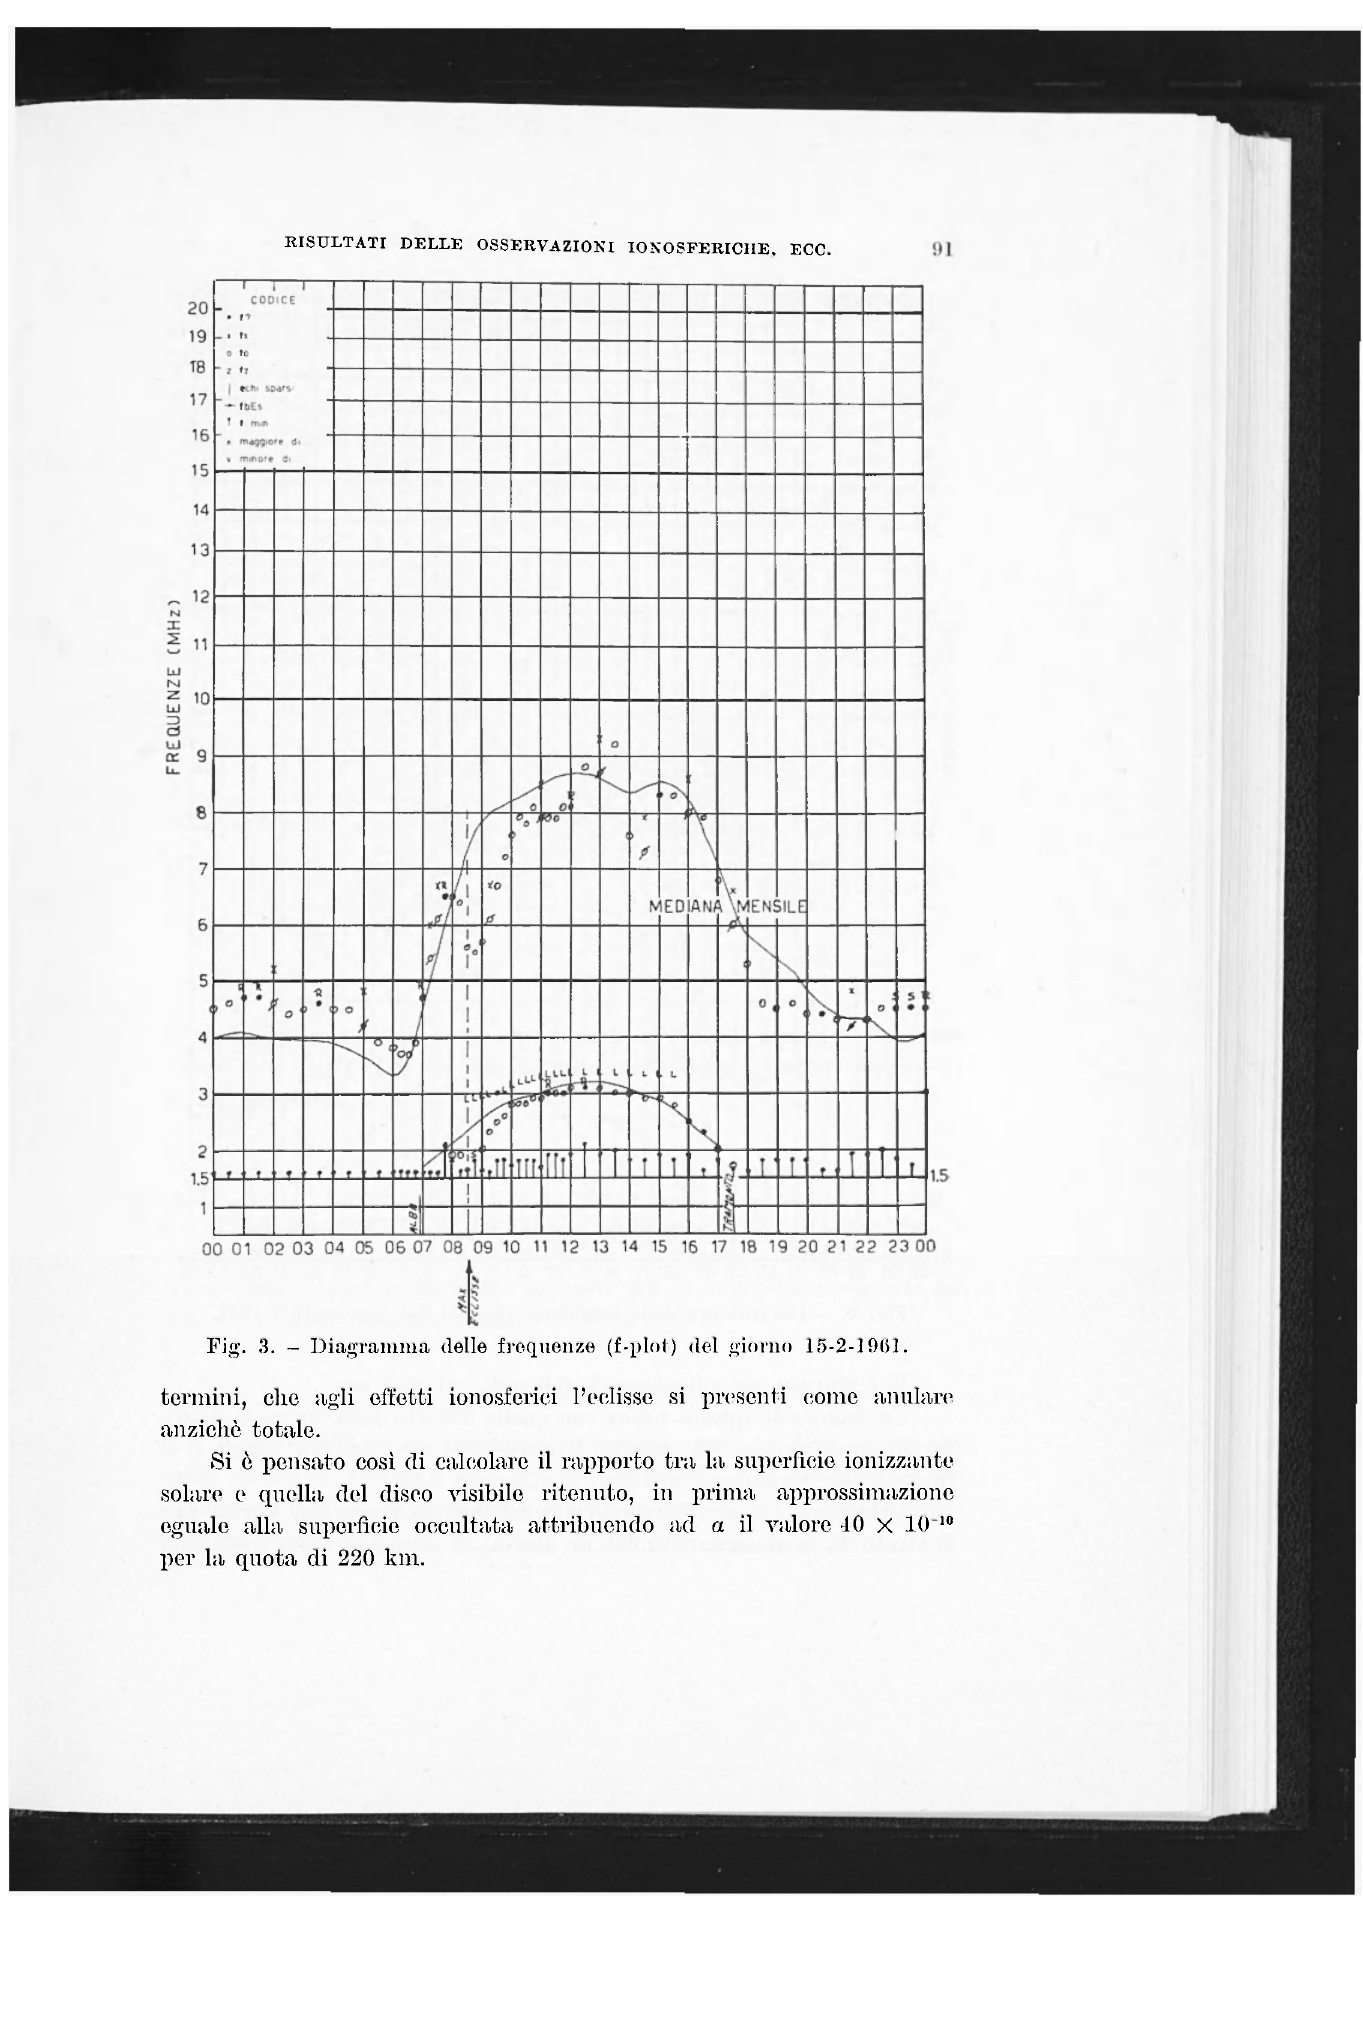
Fig. 3. - Diagramma delle frequenze (f-plot) del giorno 15-2-1961. termini, che agli effetti ionosferici l'eclisse si presenti come anulare anziché